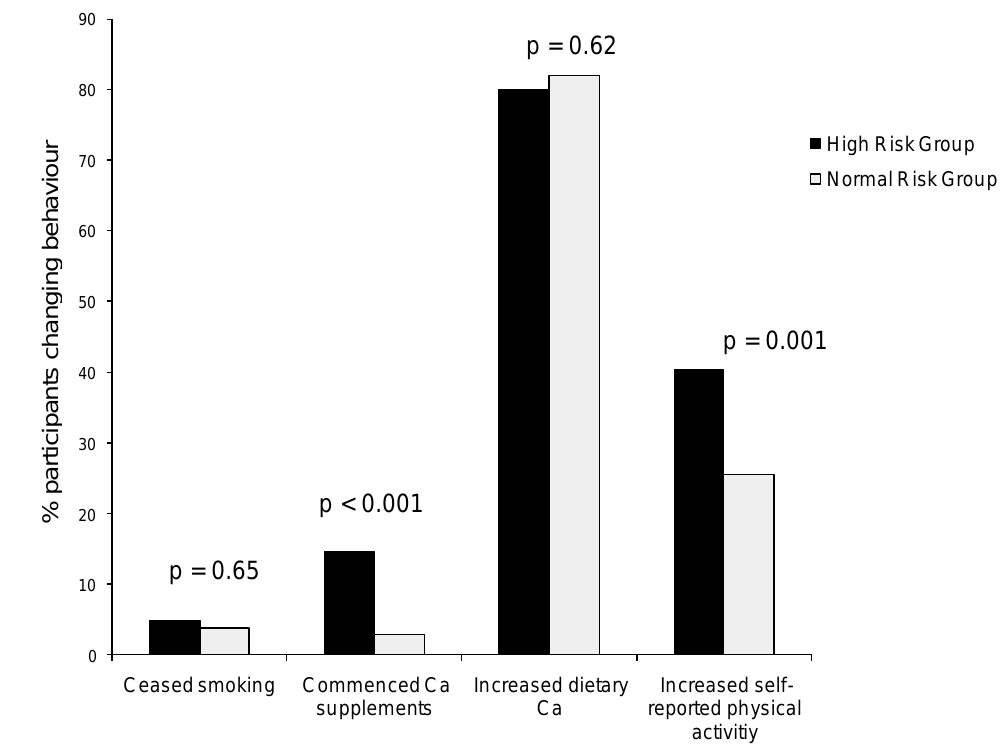
Figure 1. Effect of high risk feedback on osteoporosis preventive behavior change (adapted from Winzenberg, 2006